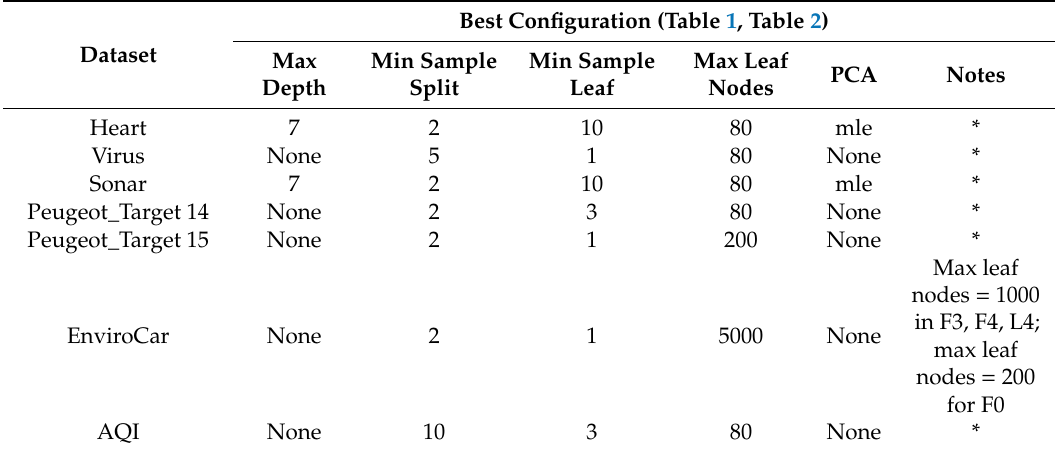
Table 13. DT corresponding configurations. Time is in ms (omitted for reasons of space). Best Configuration (Table 1, Table